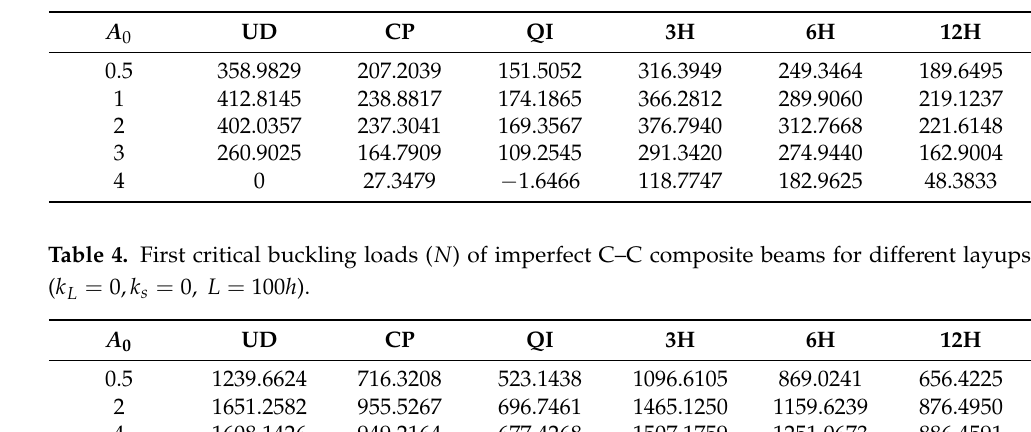
Table 3. First critical buckling loads ( N ) of imperfect S–S composite beams for different layups ( k L = 0, k s = 0, L = 100 h ).